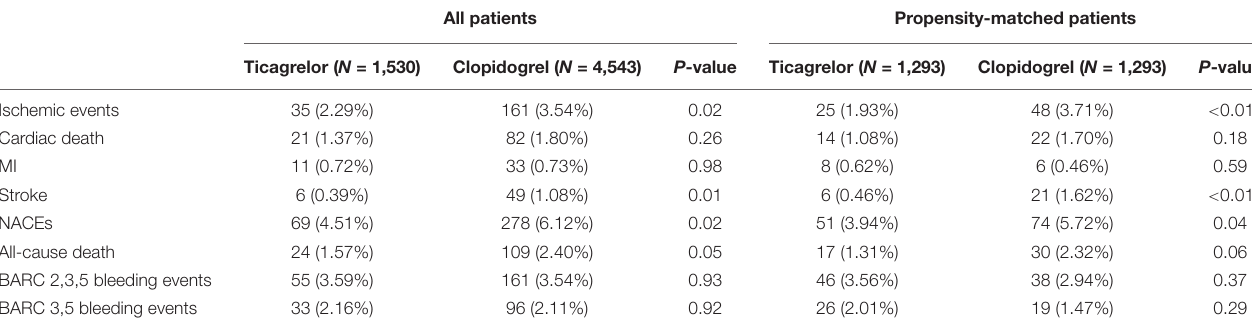
TABLE 2 | Clinical outcomes over 12 months between clopidogrel and ticagrelor in the high-risk groups before and after propensity score matching. All patients Propensity-matched